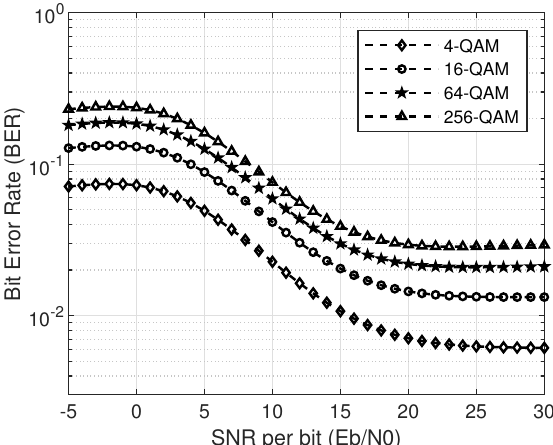
Figure 6. Bit error rate (BER) for M-quadrature amplitude modulation (M-QAM) for collision case with q = 17